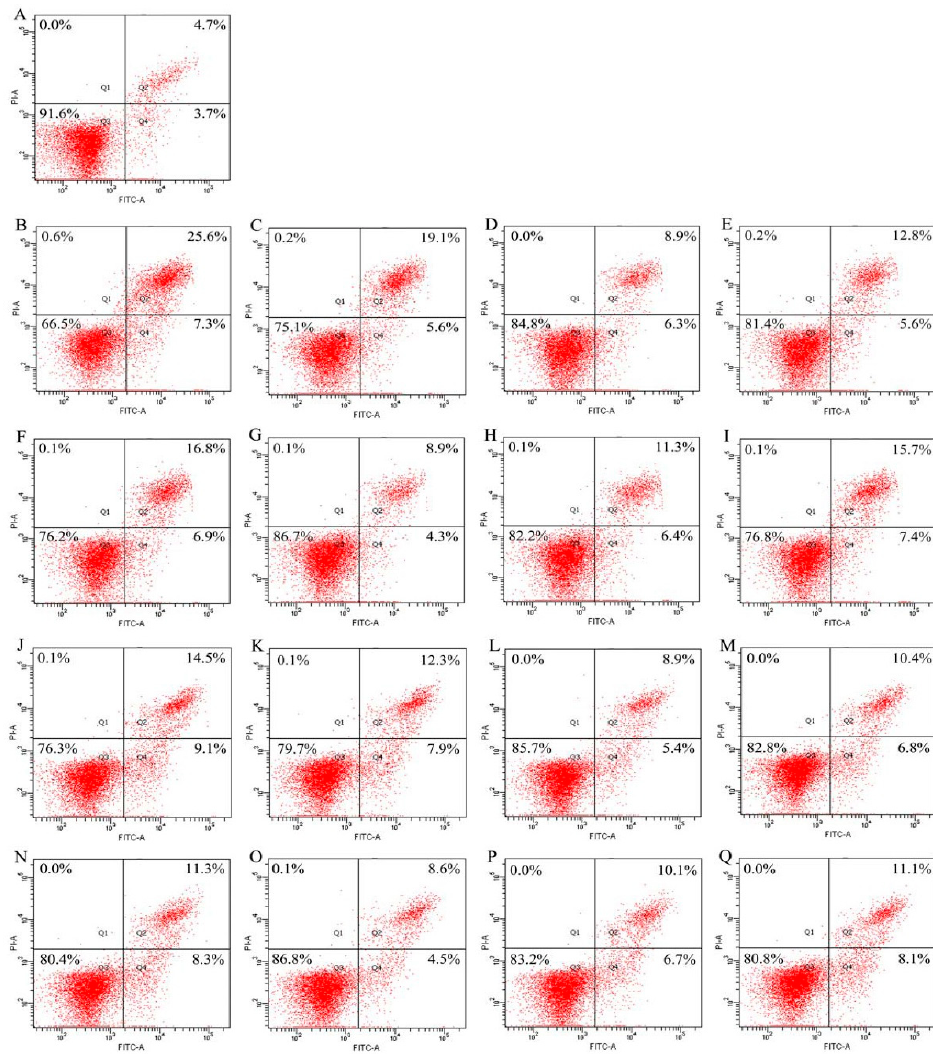
Figure 2. The apoptotic proportions in the osteoblasts detected using flow cytometry after apoptotic prevention by genistein (Gen), three hydrolysates, and three Gen-hydrolysate combinations. ( A ) control cells; ( B ) EP-treated cells; ( C – I ) the cells firstly treated by Gen, GH2, SH2, CH2, Gen-GH2, Gen-SH2, and Gen-CH2, respectively, and then treated by EP at 10 mg/L; ( J ) NaF-treated cells; ( K – Q ) the cells first treated by Gen, GH2, SH2, CH2, Gen-GH2, Gen-SH2, and Gen-CH2, respectively, and then treated by NaF at 40 mg/L. GH2, SH2, and CH2 were the hydrolysates generated from gelatin, de-isoflavoned soy protein, and casein with DH values of 13.7%, 13.5%, and 13.3%, respectively. The hydrolysates and Gen were used at 0.05 g/L and 2.5 μ g/L, respectively. EP represents etoposide, while the labeled Q1–Q4 represent necrotic, later apoptotic, viable, and early apoptotic cells, respectively.